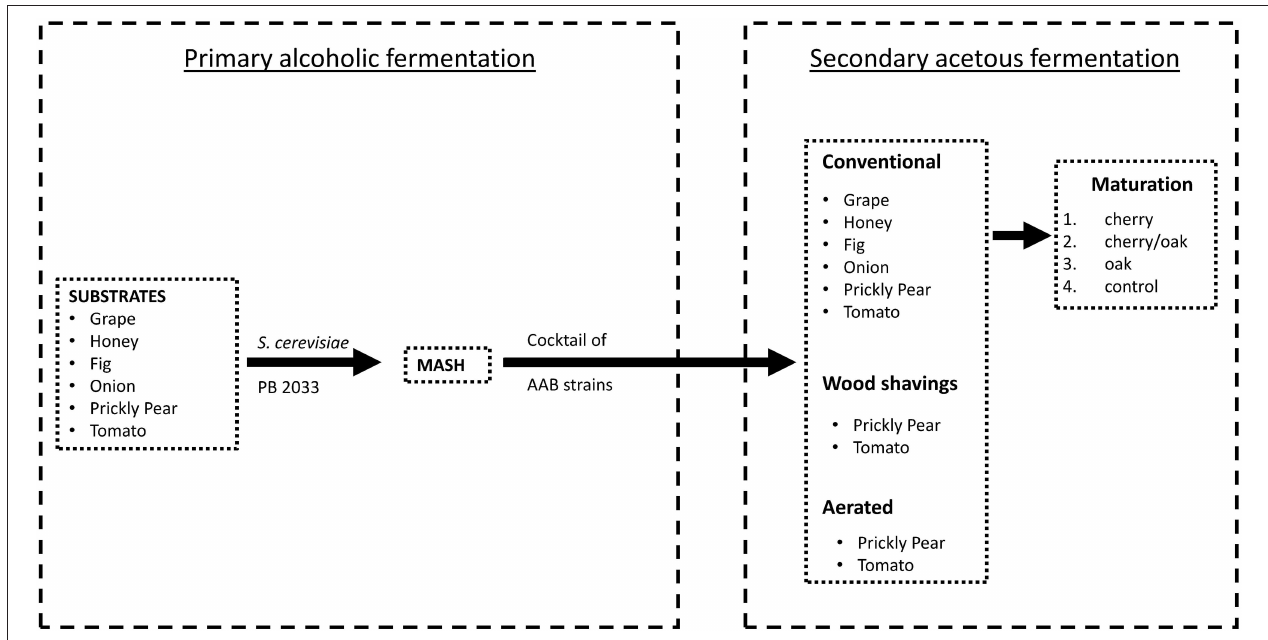
FIGURE 1 | Schematic representation of both alcoholic and acetous